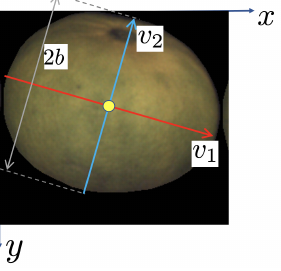
Figure 10. Sample camera view of an oblate object. The red axis is oriented as the eigenvector corresponding to the largest eigenvalue of Σ . Its length is the same as the major spheroid semi-axis, 2 A . The yellow circle is located at the center of mass of the fruit/view.